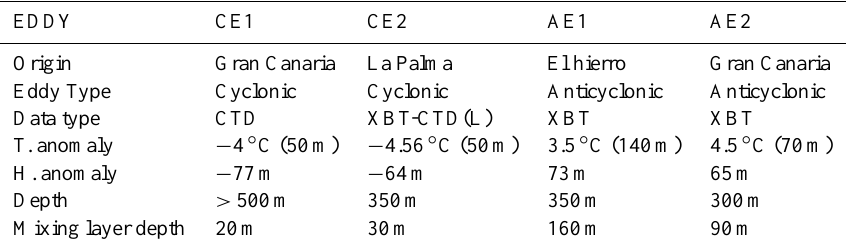
Table 1. Oceanographic properties characterizing the structure of cyclonic and anticyclonic eddies (CEs and AEs, respectively) studied. T. anomaly corresponds to the temperature